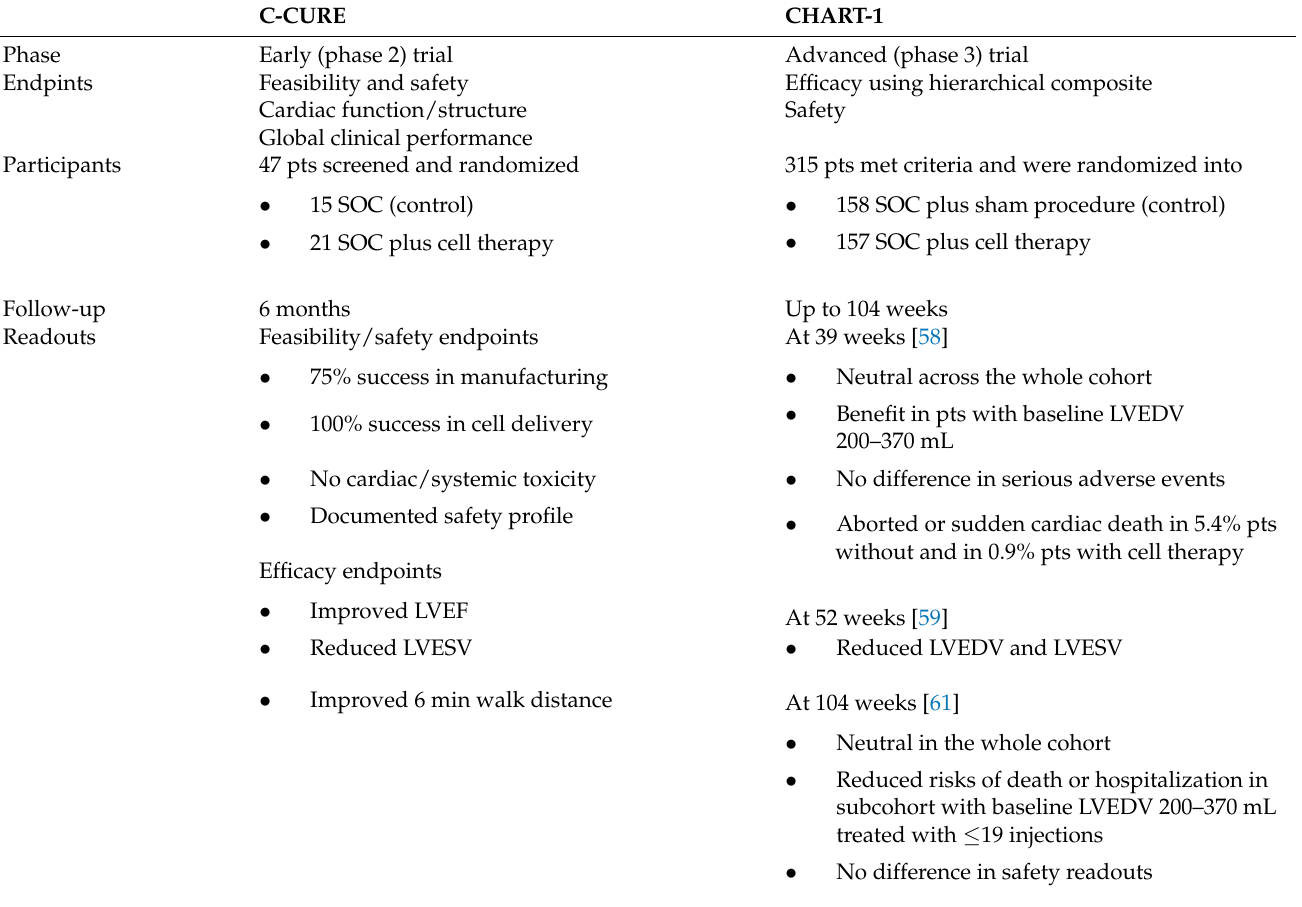
Table 1. Multi-center randomized clinical trials assessing cardiopoietic cells for chronic ischemic heart